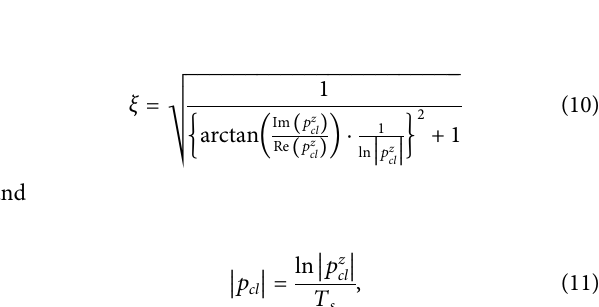
Frontiers in Energy Research |